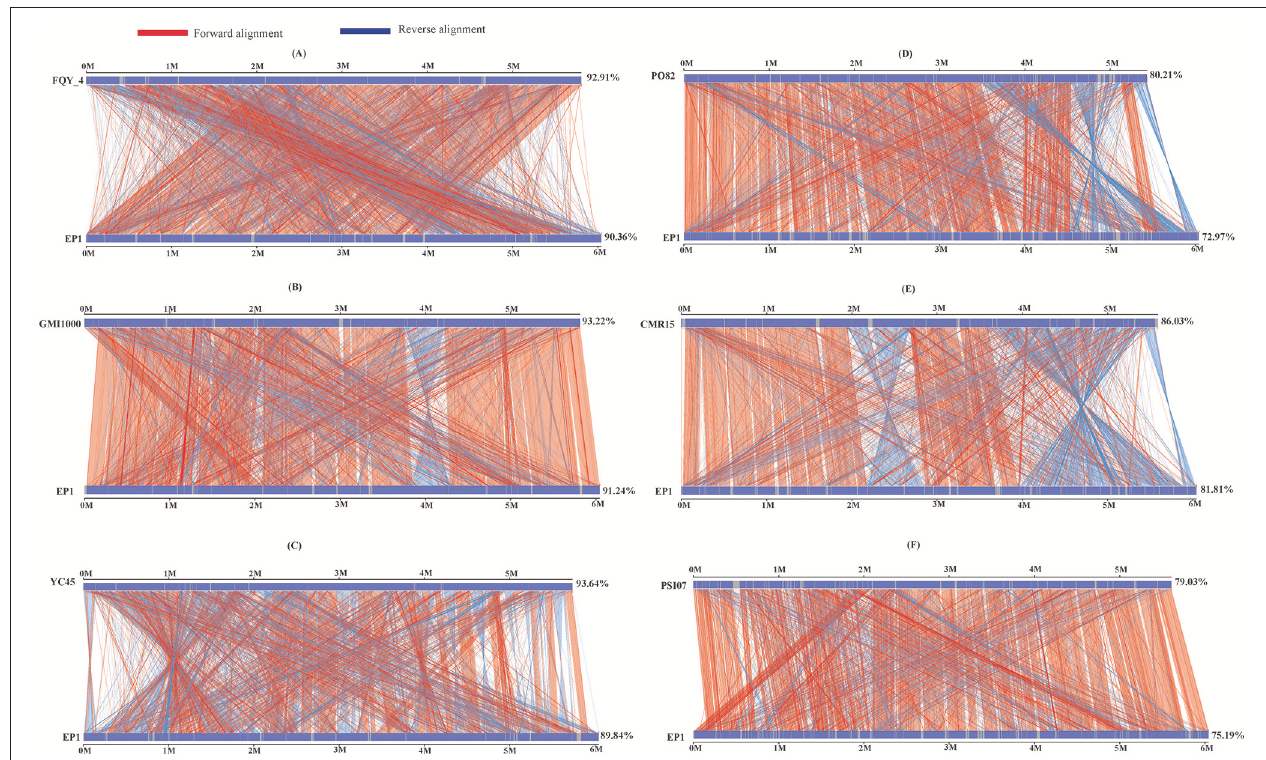
FIGURE 4 | Nucleic acid co-linearity of strain EP1 vs. strain FQY_4 (A), GMI1000 (B), YC45 (C), PO82 (D), CMR15 (E), and PSI07 (F), respectively. The sequence of EP1 is ordered according to that of the reference bacterium based on MUMmer 3.22. The upper and following axes of co-linear graph are constructed, and pairwised nucleic acid sequence of two alignments is marked in the coordinate diagram according to its position information.